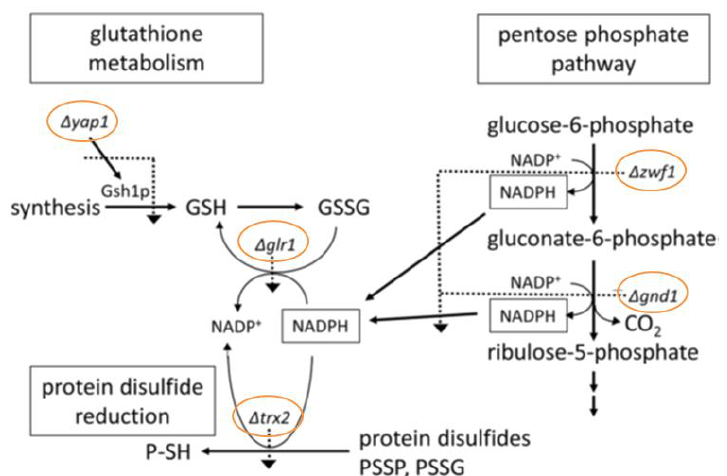
Figure 5. Schematic representation of the mutants inhibited by the selenocyanates. It also shows the activities of yeast mutants; Δyap1 (GSH synthesis and GSSG reduction), either directly ( Δglr1 ), or by blocking the production of Δzwf1 and Δgnd1 (NADPH reducing equivalents) or by suppressing the NADPH-dependent reduction of protein disulfides ( Δtrx2 , indirectly Δzwf1 and Δgnd1 ). The encircled mutants are the targets of selenocyanates showing hypersensitivity. Dotted lines show the metabolic lesions caused by the deletion mutants (modified from [30]).